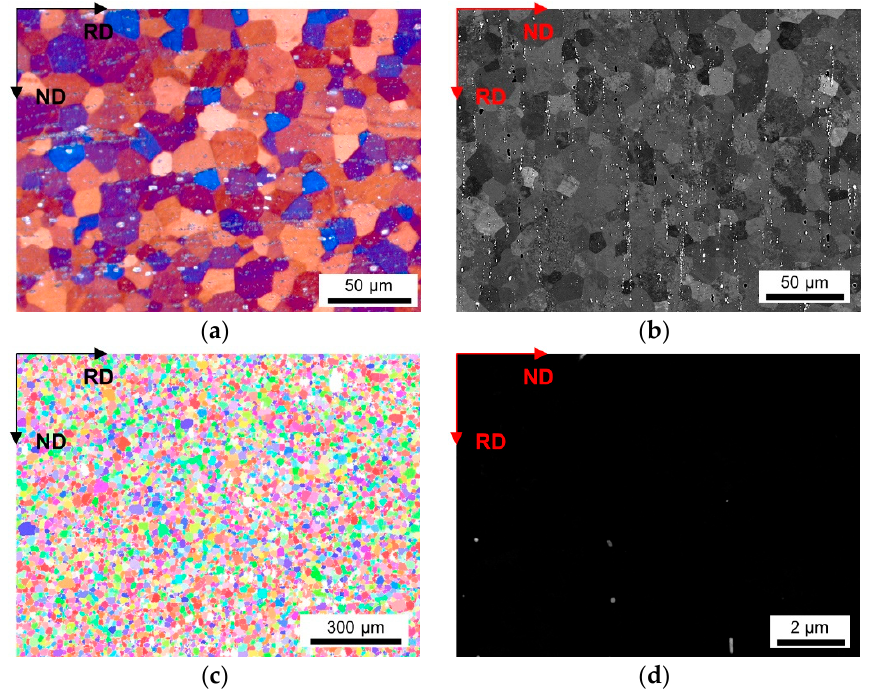
Figure A23. Microstructure of the soft annealed HFe-LMn cast under NR-C conditions, homogenized at 550 °C and cold rolled to a CRD of 63%. ( a ) LOM. ( b ) BSE image. ( c ) EBSD IPF map in RD–ND plane. ( d ) BSE micrograph showing dispersoids.